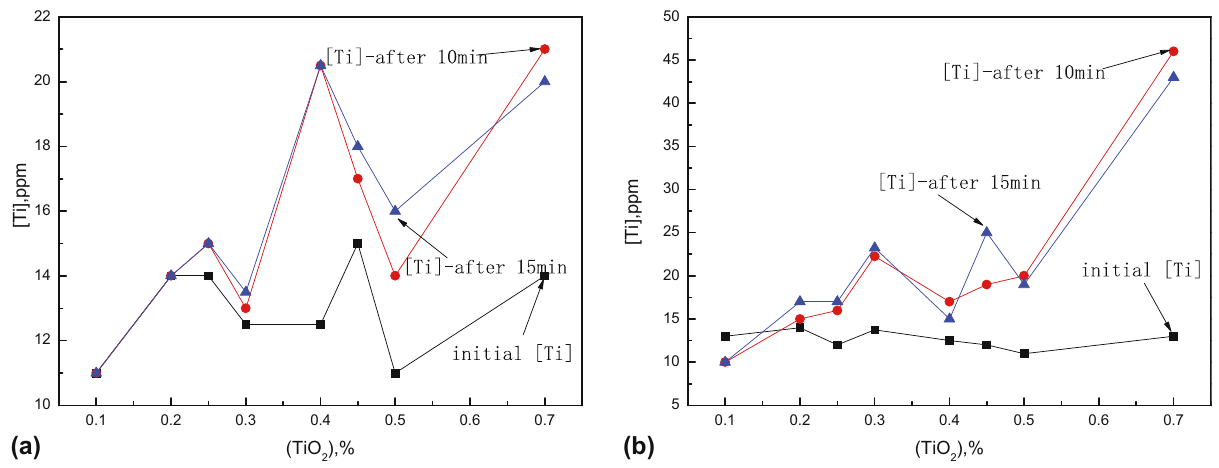
Figure 4: Content of [ Ti ] in steel varying with the content of TiO 2 in slag. ( a ) 0.030 – 0.05% [ Al ] ; ( b ) 0.070 – 0.09% [ Al ]